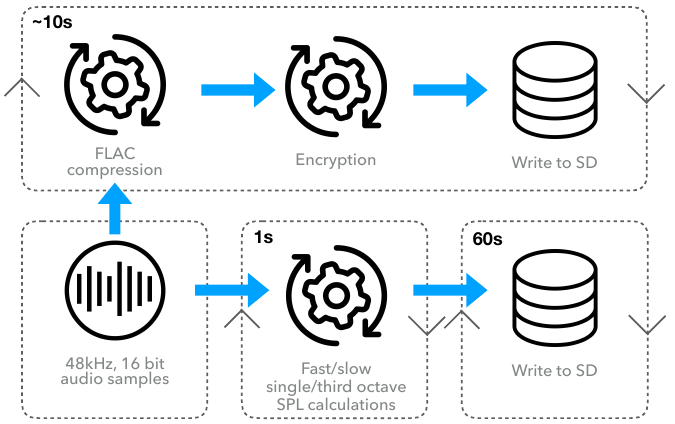
Figure 6. Operational data flow of capture module showing the time-cycle of each procedure in top